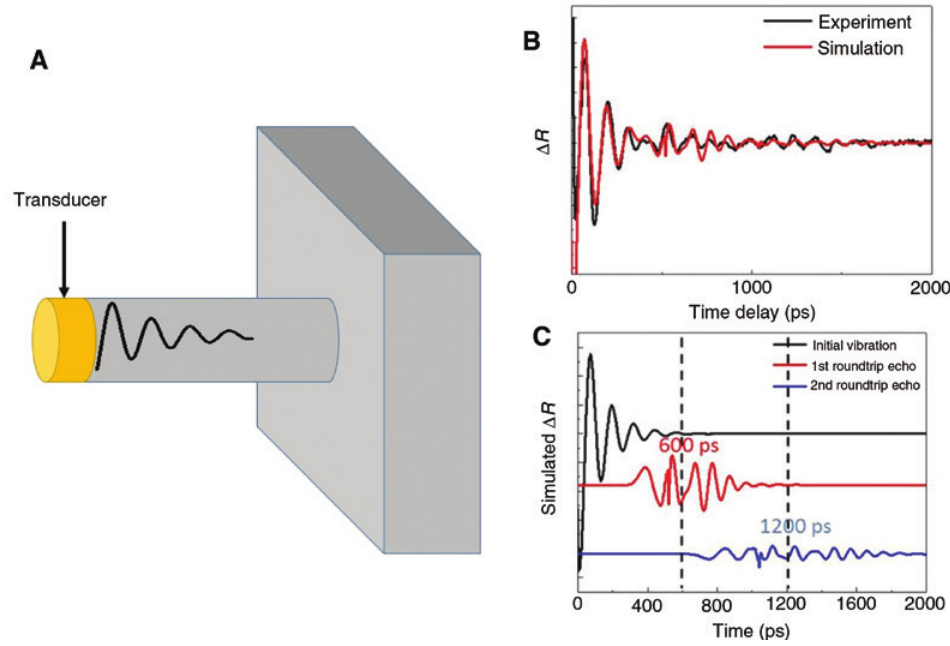
Figure 14: Propagation of phonons in a nanowire. (A) Schema representing the experimental conditions to allow the observation of propagating modes with an external transducer. (B) Transient reflectivity obtained a 720 nm long GaAs nanowire with a diameter of 230 nm and a gold particle of 30 nm of thickness after removal of the electronic contribution and simulation. (C) decomposition of the simulated signal highlighting the multiple round trips made by the phonons in the nanowire structure. Adapted from [83], with the permission of AIP Publishing.